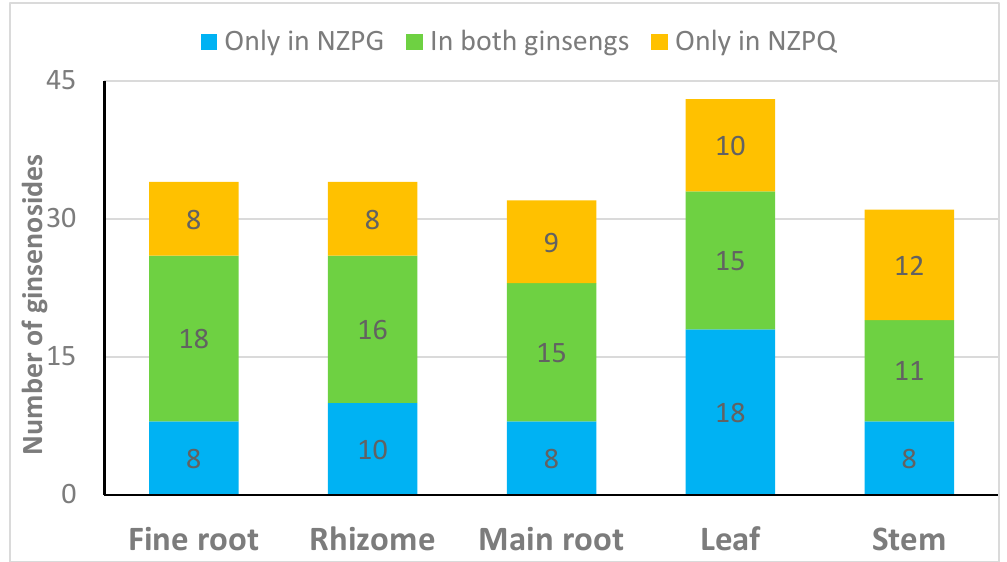
Figure 5. Distribution of ginsenosides in different parts of NZPG and NZPQ.